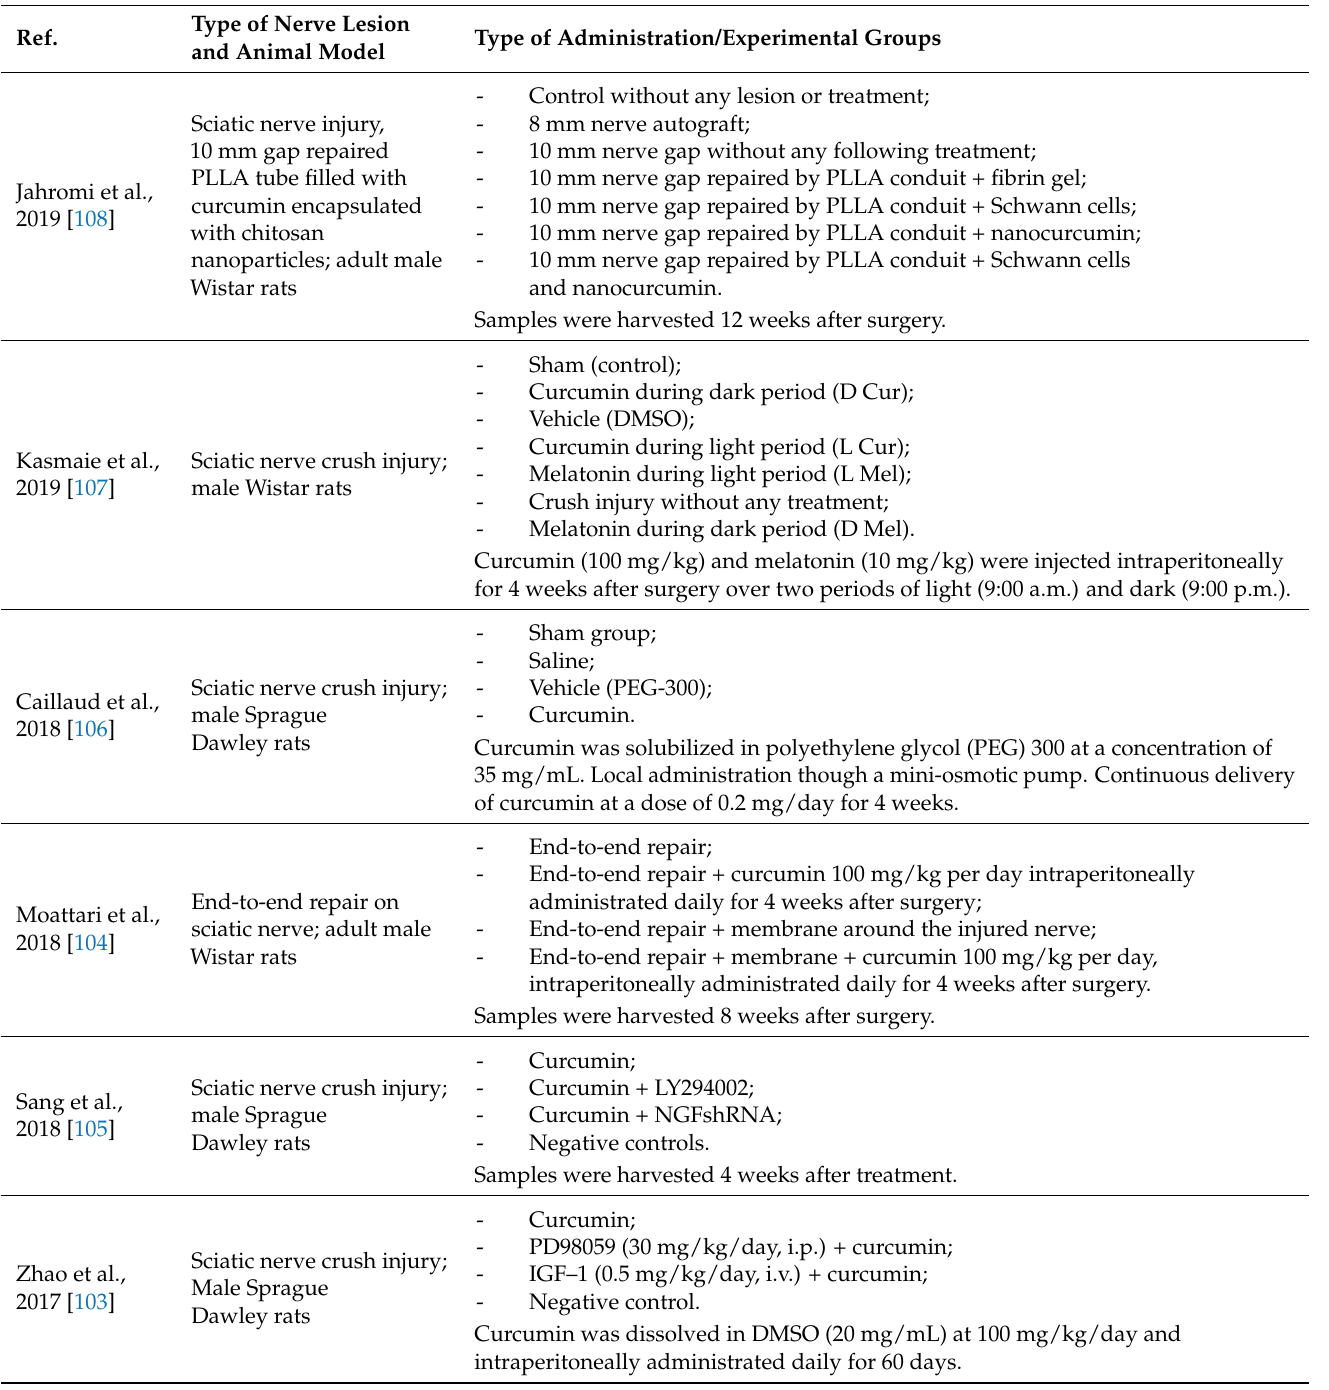
Table 6. Hydroxycinnamic acids: Table showing the experimental method (type of nerve injury and animal model), the dose, and method of administration of curcumin and ferulic acid. PLLA—poly-L- lactic acid; PEG—polyethylene glycol. Included references are listed ascending in accordance to